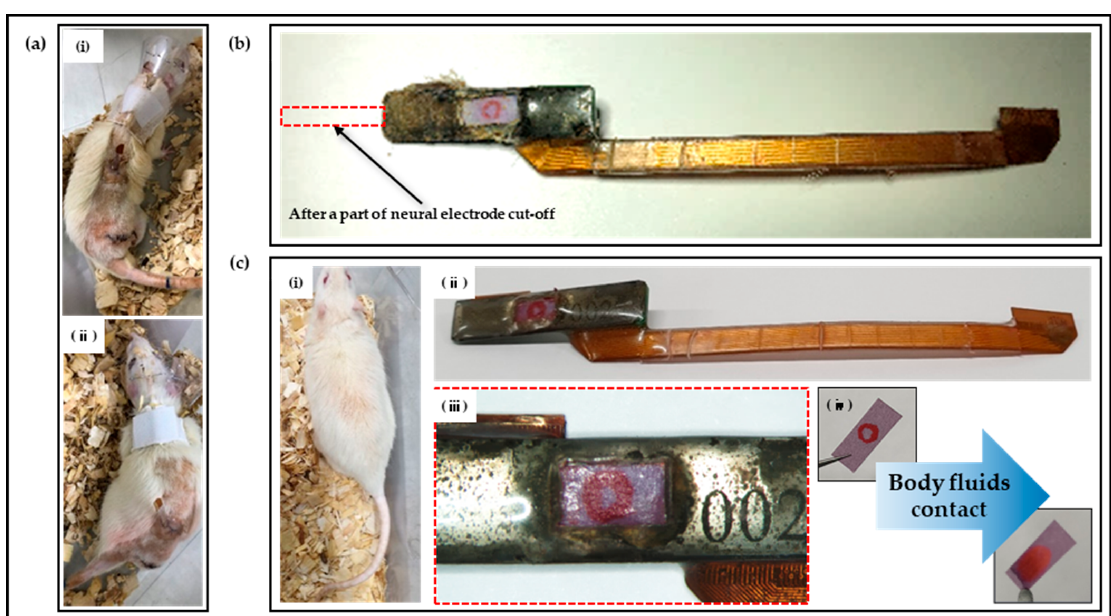
Figure 8. Results of in vivo experiments. ( a ) Two rats after packaged neural electrode implantations, ( b ) photograph of neural interface extracted after 8 months of implantation, ( c- ⅰ ) a rat of 18 months after implantation (its hair grew back in the surgical area and maintained a healthy state), ( c- ⅱ ) photograph of neural interface extracted after 18 months of implantation, ( c- ⅲ ) no discoloration of litmus paper and diffusion of aqueous ink, and ( c- ⅳ ) an example of discoloration of litmus paper and diffusion of aqueous ink with bodily fluid contact .